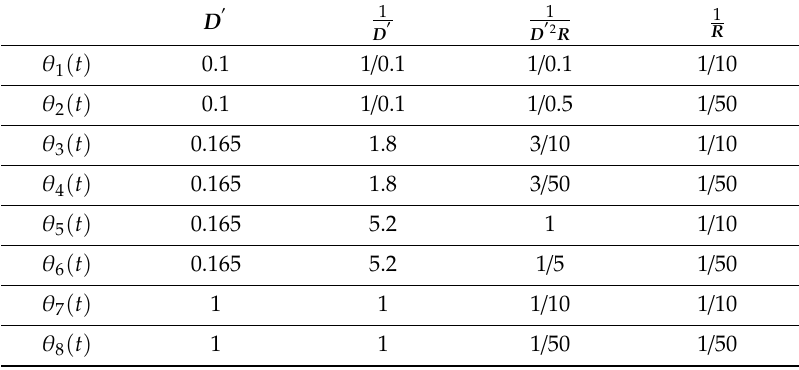
Table 2. Vertices of the polytopic covering of P